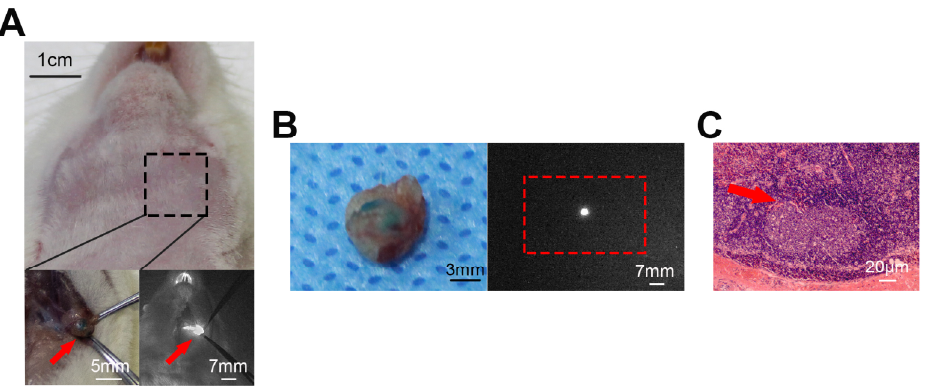
Figure 2. Inspections of the surgical field and the resected SLN. ( A ) Photographs of a rat before dissection ( top ), neck region after dissection ( bottom left ), and fluorescence observation after dis- section ( bottom right ). ( B ) The same SLN after resection from the above rat. Shown are the bright- view image ( left ) and NIR fluorescence image ( right ). ( C ) Hematoxylin-eosin staining of the SLN (40× magnification). The arrow shows a germinal center of the SLN.